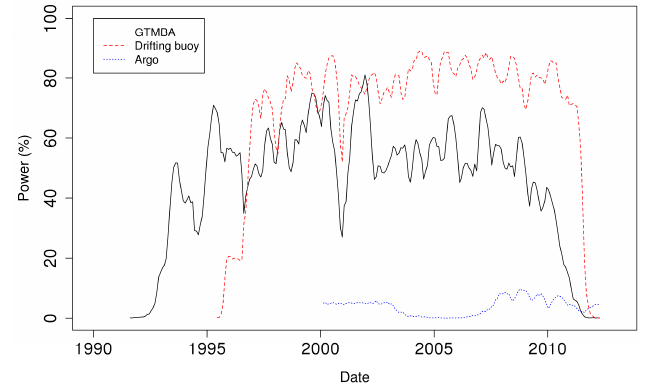
Figure 10. Estimated statistical power (%) for detection of 0.05 K step in the satellite data given the observing system characteristics and analysis configuration listed in Table